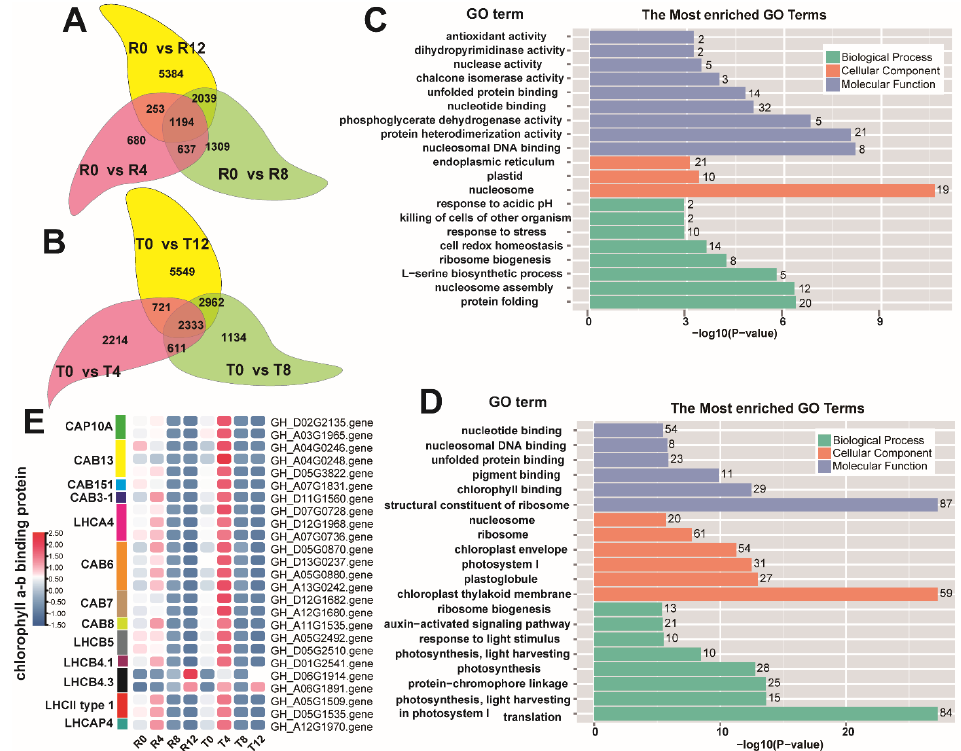
Figure 4. Analysis of the DEGs from the intra-groups of the two cotton cultivars. ( A ) Venn diagram showing the DEG numbers in each comparison group of the sensitive cultivar; ( B ) Venn diagram showed the DEG numbers in each comparison group of the tolerant cultivar; ( C ) the top 20 GO terms of the overlap DEGs in the sensitive cultivar; ( D ) the top 20 GO terms of the overlap DEGs in the tolerant cultivar; ( E) expression profile of the chlorophyll a-b binding protein genes.